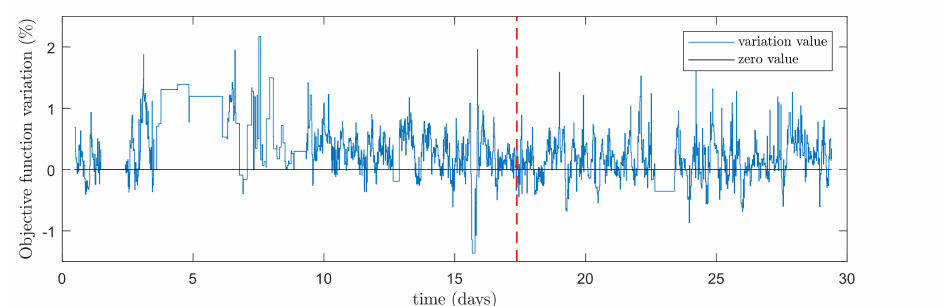
Figure 8. Optimization results: variation of the optimal objective function from the reconciliation solution.